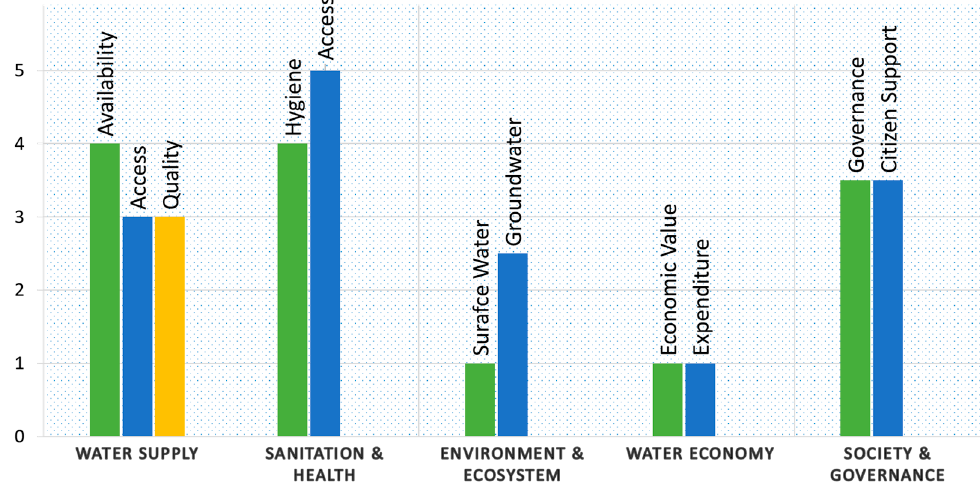
Figure 3. Islamabad’s UWSI Indicators.